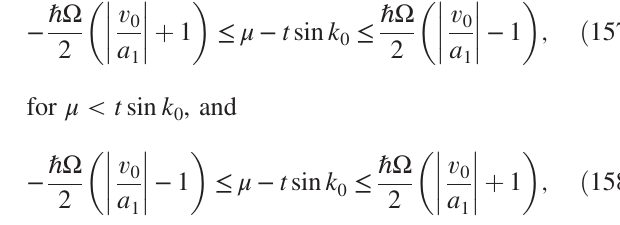
Fig. 4. First, the tilting of each Dirac cone due to v 0 prevents the gyration current from compensation of the contributions from k 0 (cid:4) k . Second, cancellation between the gyration current from the two Dirac cones is suppressed